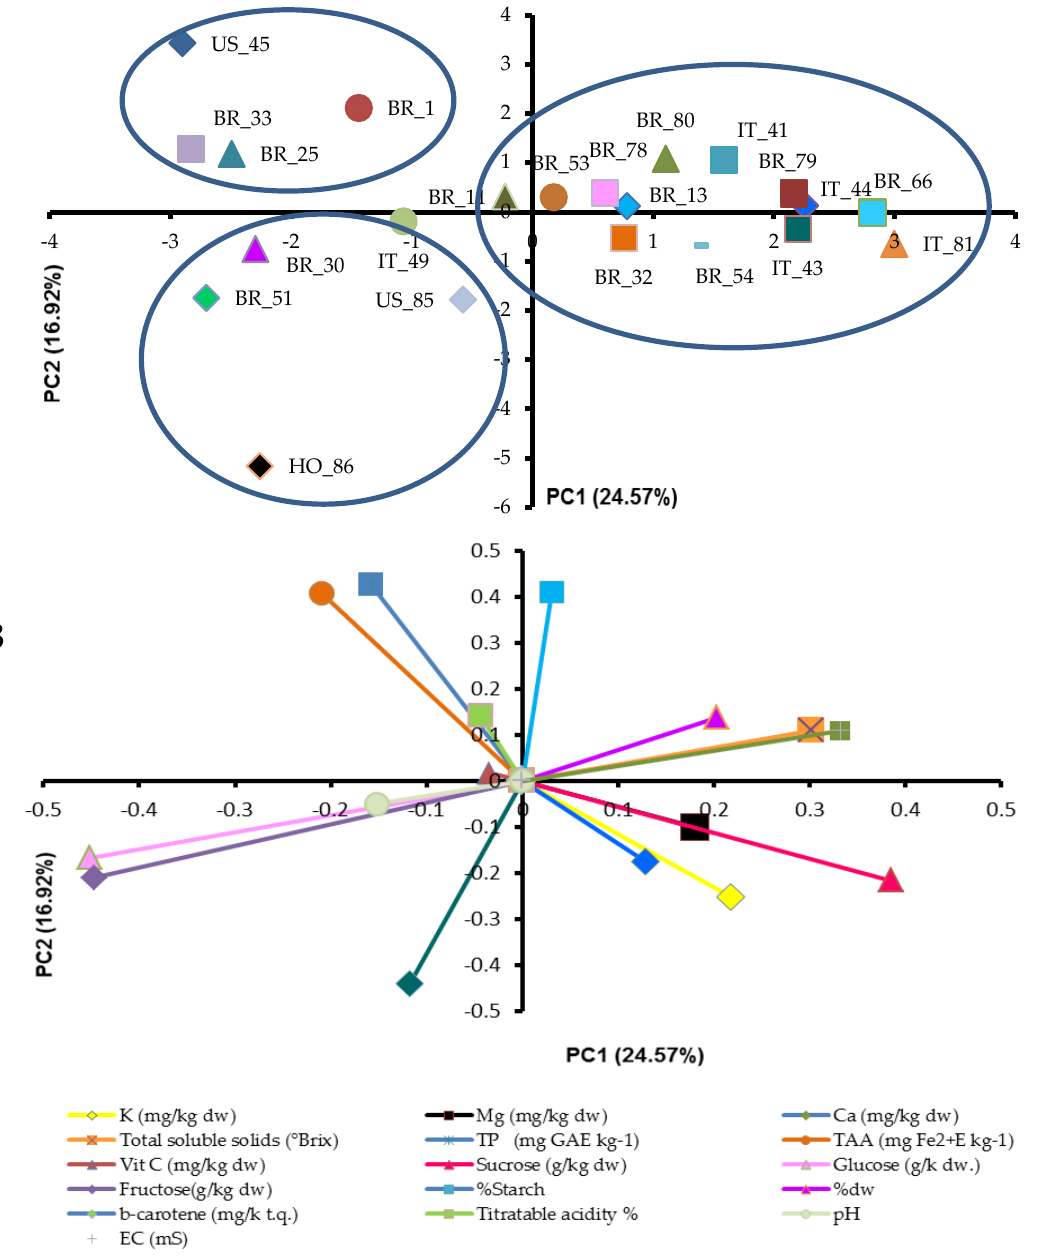
Figure 3. Principal components analysis (PCA) of the sweet potato core collection based on qualitative traits: ( A ) Score plot of the first two principal components (PC1 and PC2) for the 22 sweet potatoes. ( B ) Eigenvectors of the variables measured for the first two principal components. Loadings (eigenvalues) for the first and second principal components were equal to 25% and 17%, respectively. TP: total phenols; TAA: total antioxidant activity; dw: dry weight.